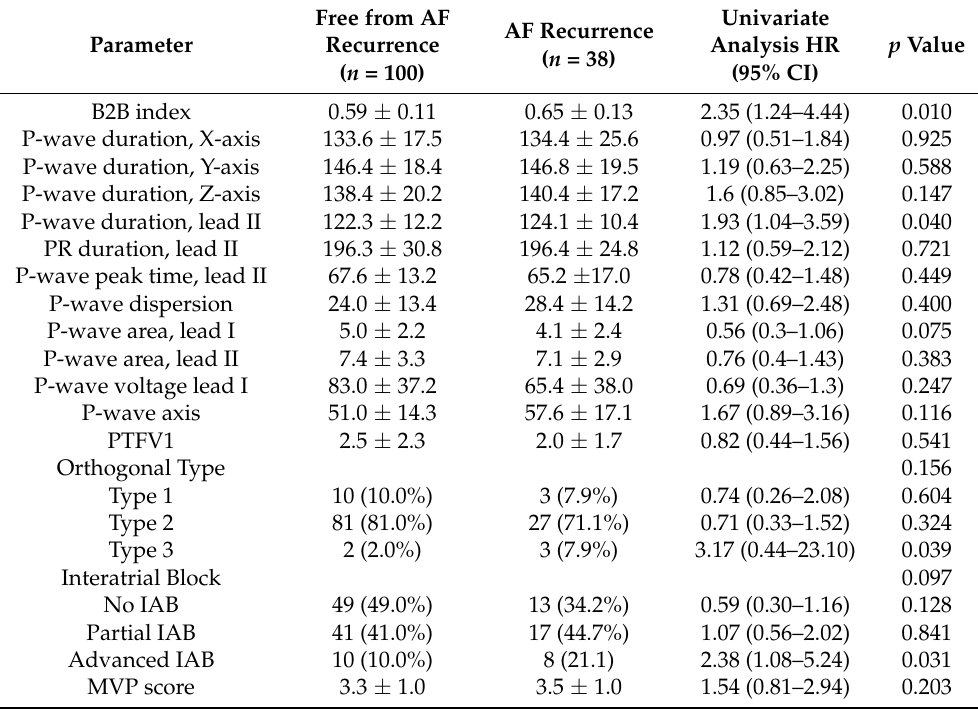
Table 4. ECG parameters comparison.